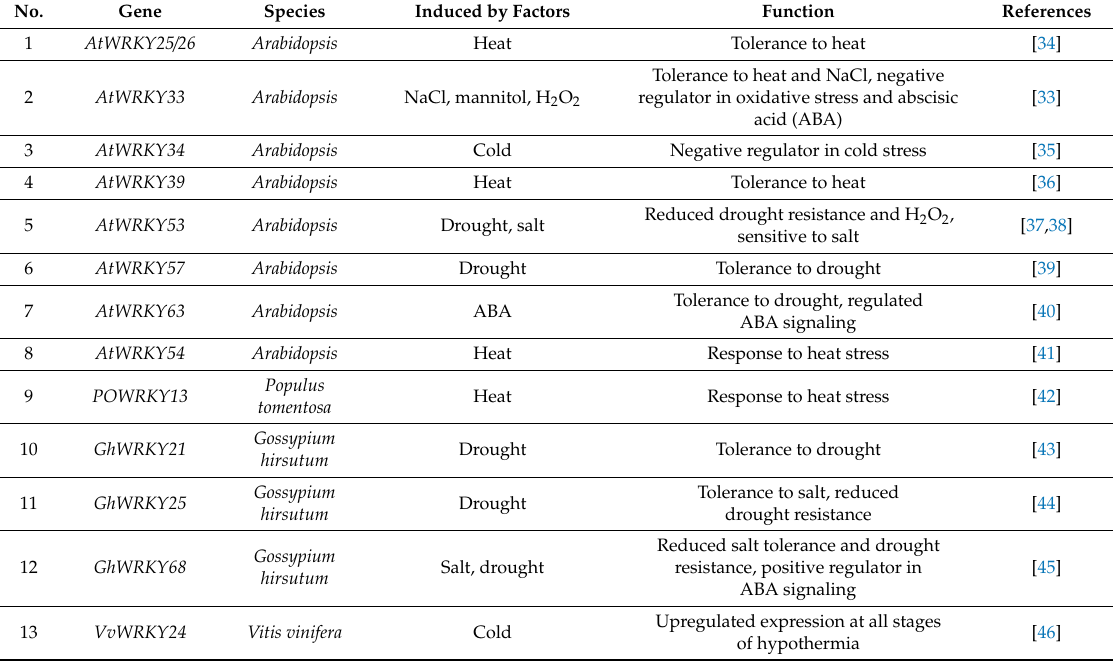
Table 1. WRKY transcription factors (TFs) involved in abiotic stress responses in